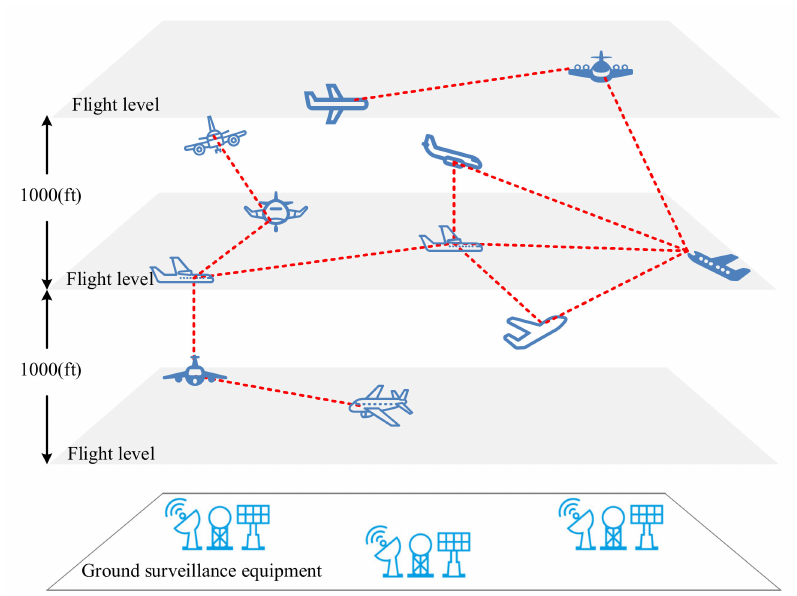
Figure 1. Aircraft network